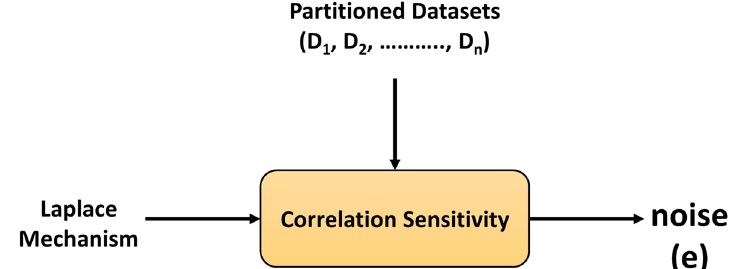
Fig. 5 Step 4 of proposed methodology